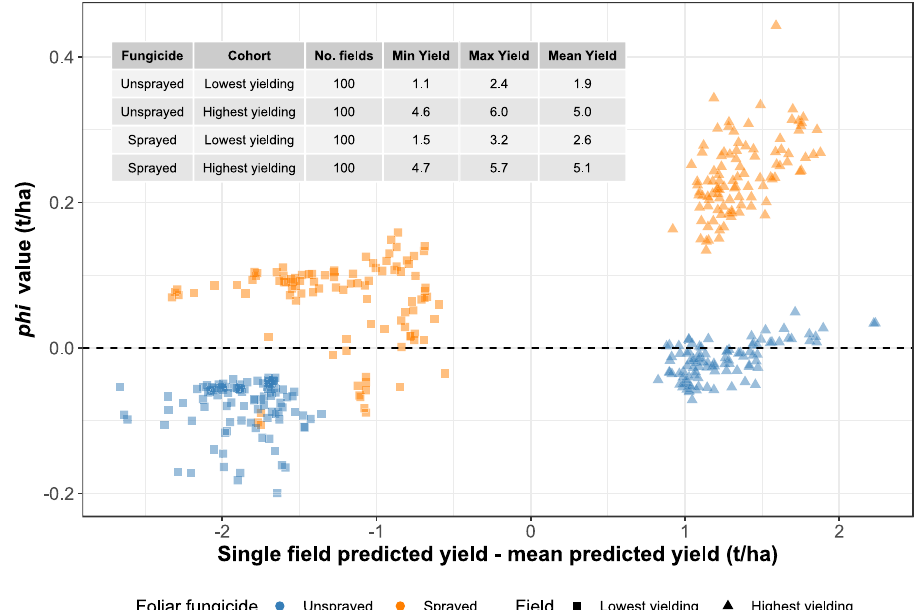
Figure 4. Shapley phi values attributed to foliar fungicides for four cohorts of soybean fields. The cohorts are (i) the 100 highest-yielding fungicide-treated fields, (ii) the 100 lowest-yielding fungicide-treated fields, (iii) the 100 highest-yielding unsprayed fields, and (iv) the 100 lowest-yielding unsprayed fields. The insert table summarizes the minimum (Min), maximum (Max) and mean predicted yields (t/ha) for each of the four cohorts. Point color represents whether fields were sprayed or unsprayed, whereas point shape represents whether fields were in the lowest-yielding or highest-yielding